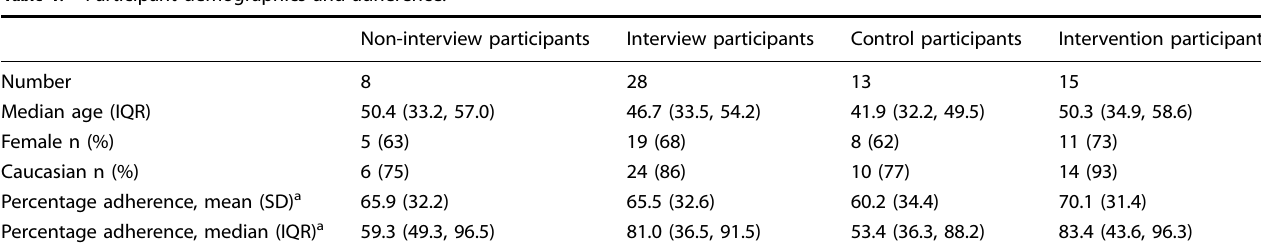
Table 1. Participant demographics and